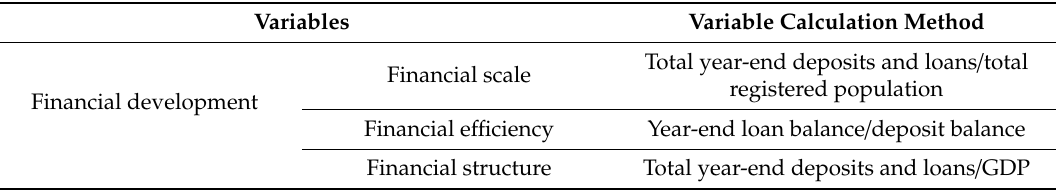
Table 1. Financial development index